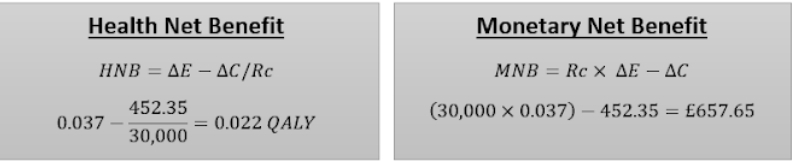
Table 4. Sensitivities of Botox and oxybutynin.